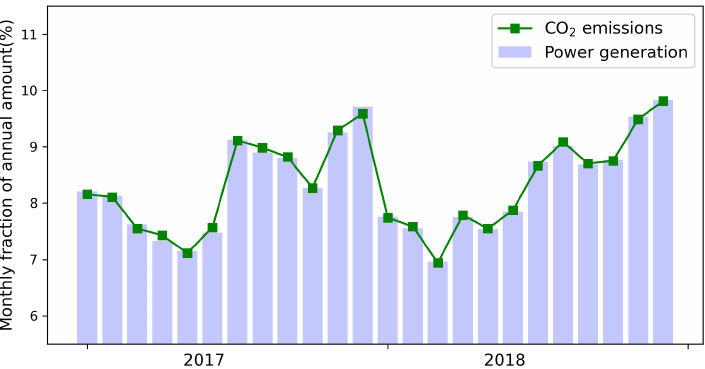
Figure 3. Monthly profiles of thermal power generation and coal-fired power-plant CO 2 emissions.